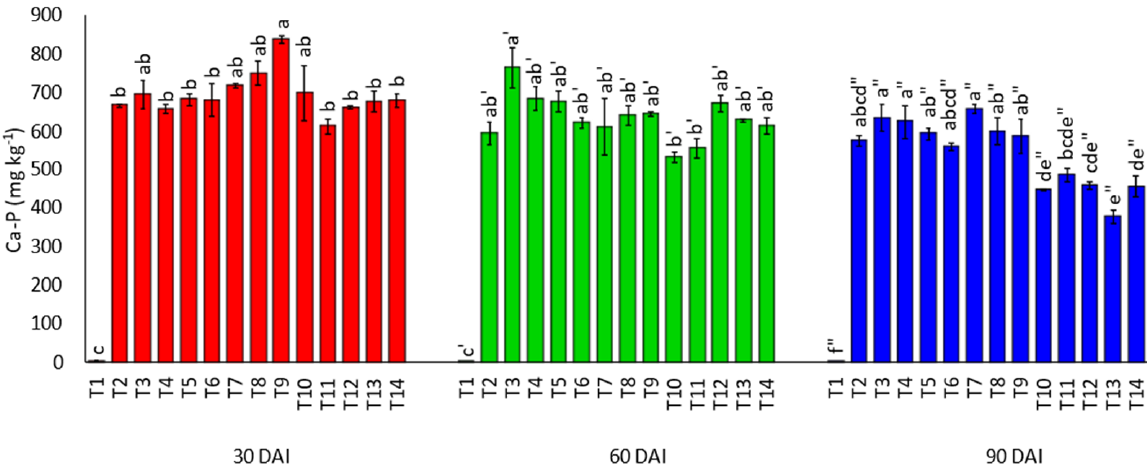
Figure 20. Effects of treatments on calcium-bound phosphorus after thirty, sixty, and ninety days of incubation, where T1: soil alone, T2: Egypt rock phosphate alone, T3: Egypt rock phosphate + 100% charcoal, T4: Egypt rock phosphate + 100% sago bark ash, and T5: Egypt rock phosphate + 100% charcoal + 100% sago bark ash, T6: Egypt rock phosphate + 75% charcoal + 75% sago bark ash, T7: Egypt rock phosphate + 50% charcoal + 75% sago bark ash, T8: Egypt rock phosphate + 25% charcoal + 75% sago bark ash, T9: Egypt rock phosphate + 75% charcoal + 50% sago bark ash, T10: Egypt rock phosphate + 50% charcoal + 50% sago bark ash, T11: Egypt rock phosphate + 25% charcoal + 50% sago bark ash, T12: Egypt rock phosphate + 75% charcoal + 25% sago bark ash, T13: Egypt rock phosphate + 50% charcoal + 25% sago bark ash, and T14: Egypt rock phosphate + 25% charcoal + 25% sago bark ash. Means with different letter(s) within the same incubation period indicate significant differences between treatments according to Tukey’s HSD test at p ≤ 0.05, i.e., a > b > c. Bars represent the mean values ±